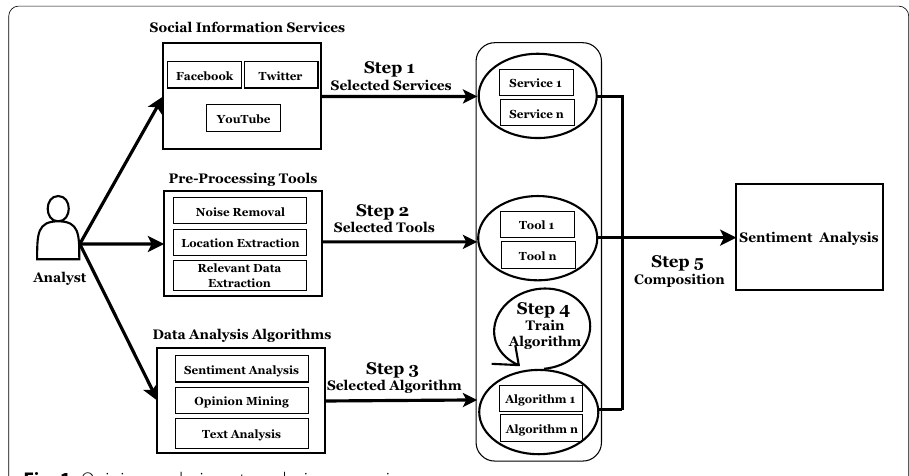
Fig. 1 Opinion analysis system design